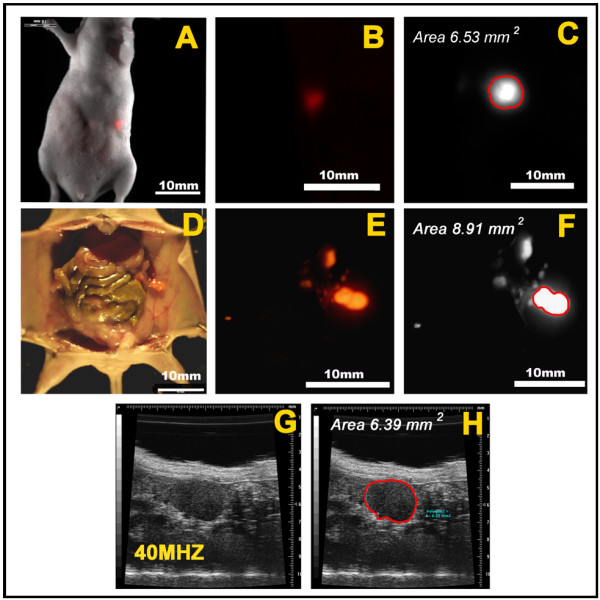
Fluorescence and ultrasound imaging of orthotopic pancreatic tumor implants and measurement of tumor size. A-H. This mouse was imaged two weeks after orthotopic injection of a human pancreatic cell line (XPA-1) stably expressing red fluorescent protein (RFP). A-C. Evaluation of tumor size by whole body imaging of an anesthetized mouse. A. Bright field and color fluorescence images were overlaid to show the coronal image of the fluorescent tumor. B. Enlarged whole body fluorescence image of tumor. This image was obtained using a color (non-quantitative) fluorescence imaging camera. C. Monochrome (quantitative) fluorescence image of the tumor shown in panels A and B. This coronal image was analyzed using ImageJ software to determine the cross-sectional size of the tumor in millimeters squared (mm2). D-F. Evaluation of tumor size at necropsy. D. Overlay of bright field and color fluorescence images showing the fluorescent tumor implant at necropsy. E. Enlarged color fluorescence-only image of the tumor as shown in D. F. As for panel C above, the cross-sectional size of the tumor shown in panels D and E was determined using ImageJ software. G. This ultrasound image of the pancreatic tumor mass was obtained using a Visual Sonics Vevo 770 small animal ultrasound imaging system. With the anesthetized mouse in a lateral position, the 40 MHz ultrasound transducer was oriented to obtain coronal image slices of the tumor. H. Image showing the tumor at its maximum cross sectional size in the coronal plane. Vevo 770 imaging software was used to determine the cross sectional size (in mm2) of the tumor.